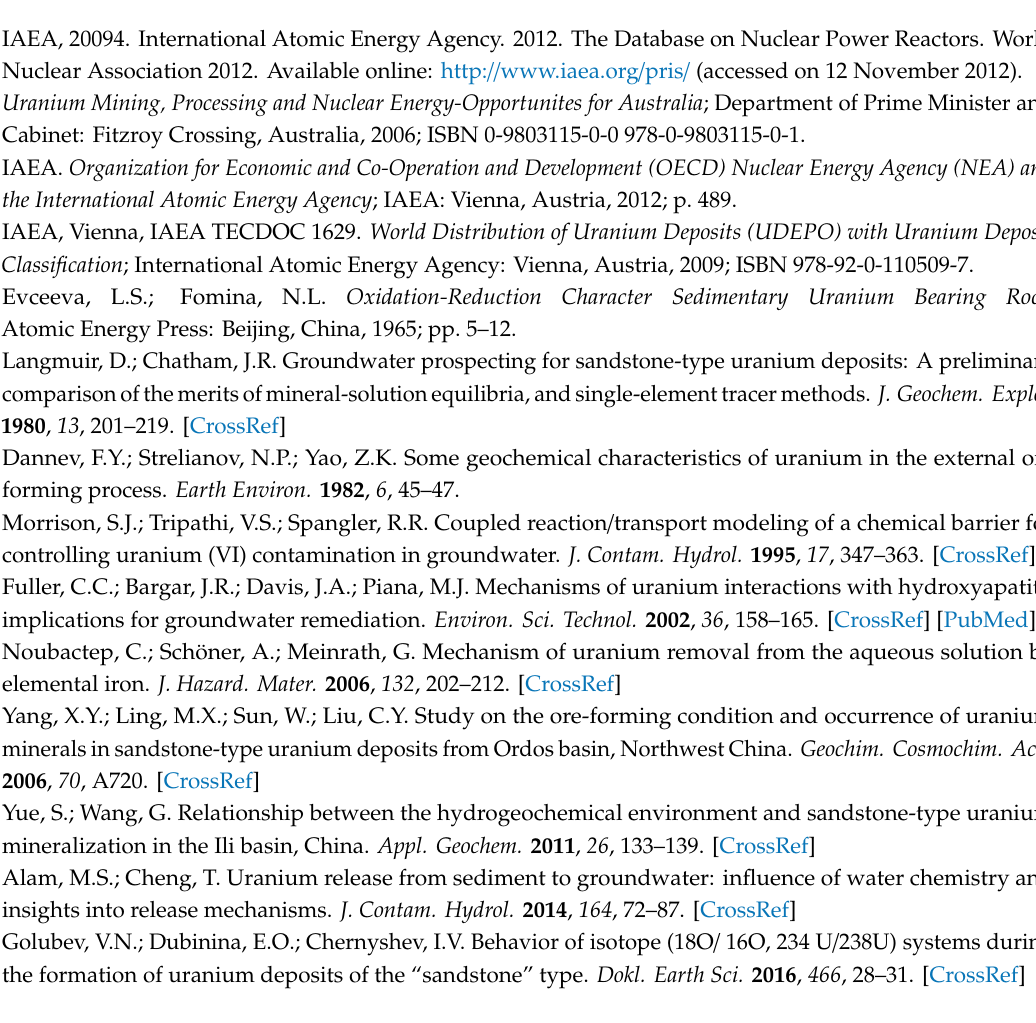
Figure S1: Change in uranium concentration in the leaching